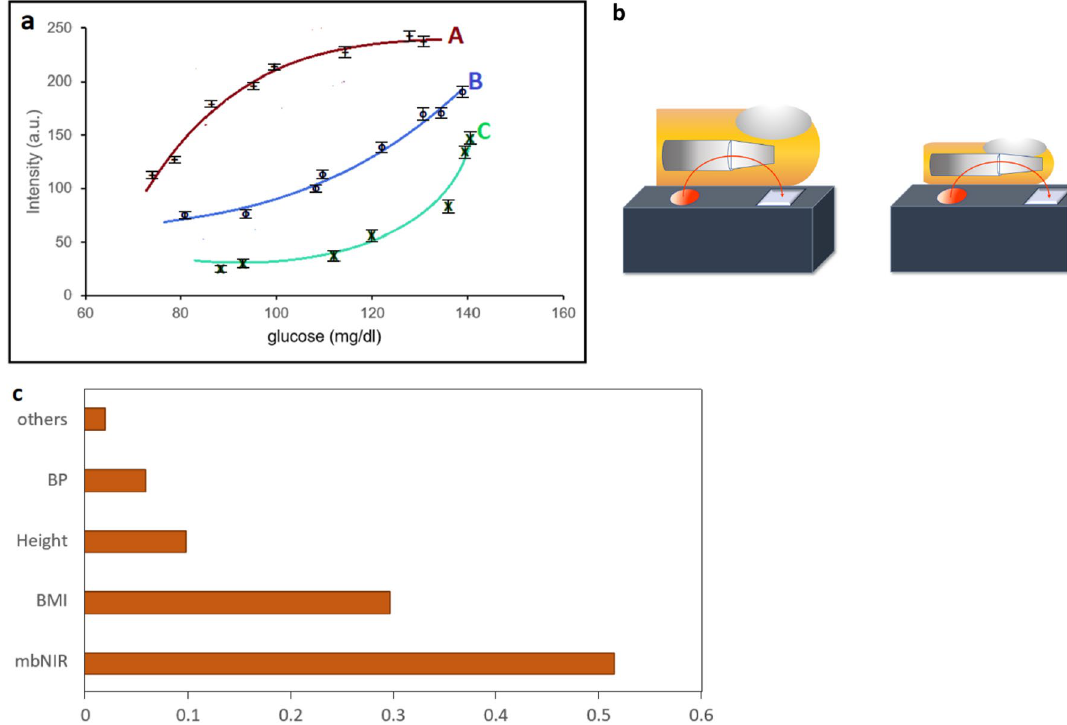
Figure 1. ( a ) A graph showing NIR readout and blood glucose of two subjects with different PMF. For persons A, B and C we obtained different glucose curves without PMF information. Therefore, we imposed PMF into SDNN to predict non-invasive blood glucose with significantly improvement in accuracy. ( b ) Illustrate different bones and skin thickness which contribute the difference in NIR vs glucose curves ( c ) feature importance of each